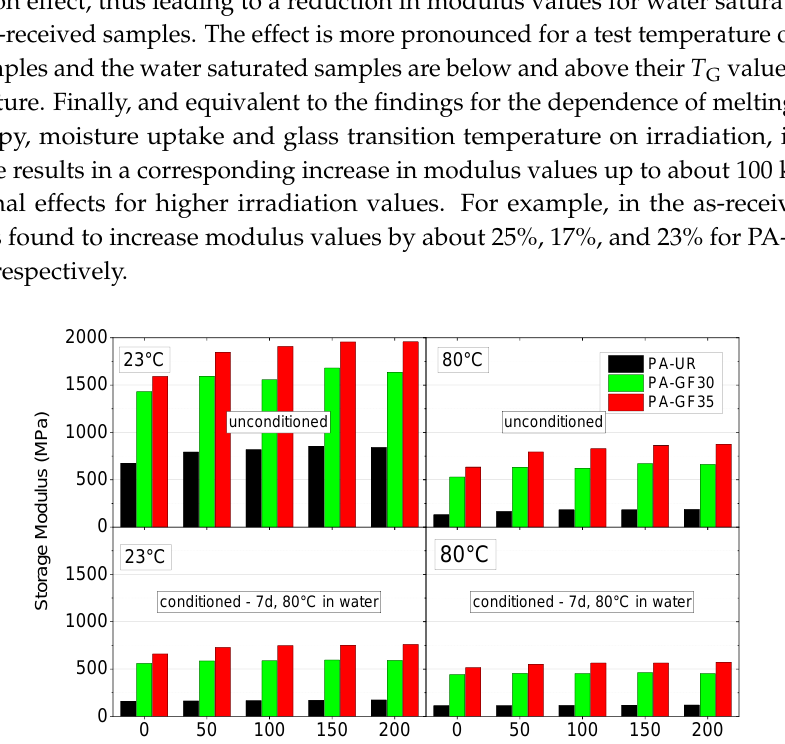
Figure 8. Storage modulus at 23 °C and 80 °C for the three PA grades depicting the effect of water absorption and irradiation dose.